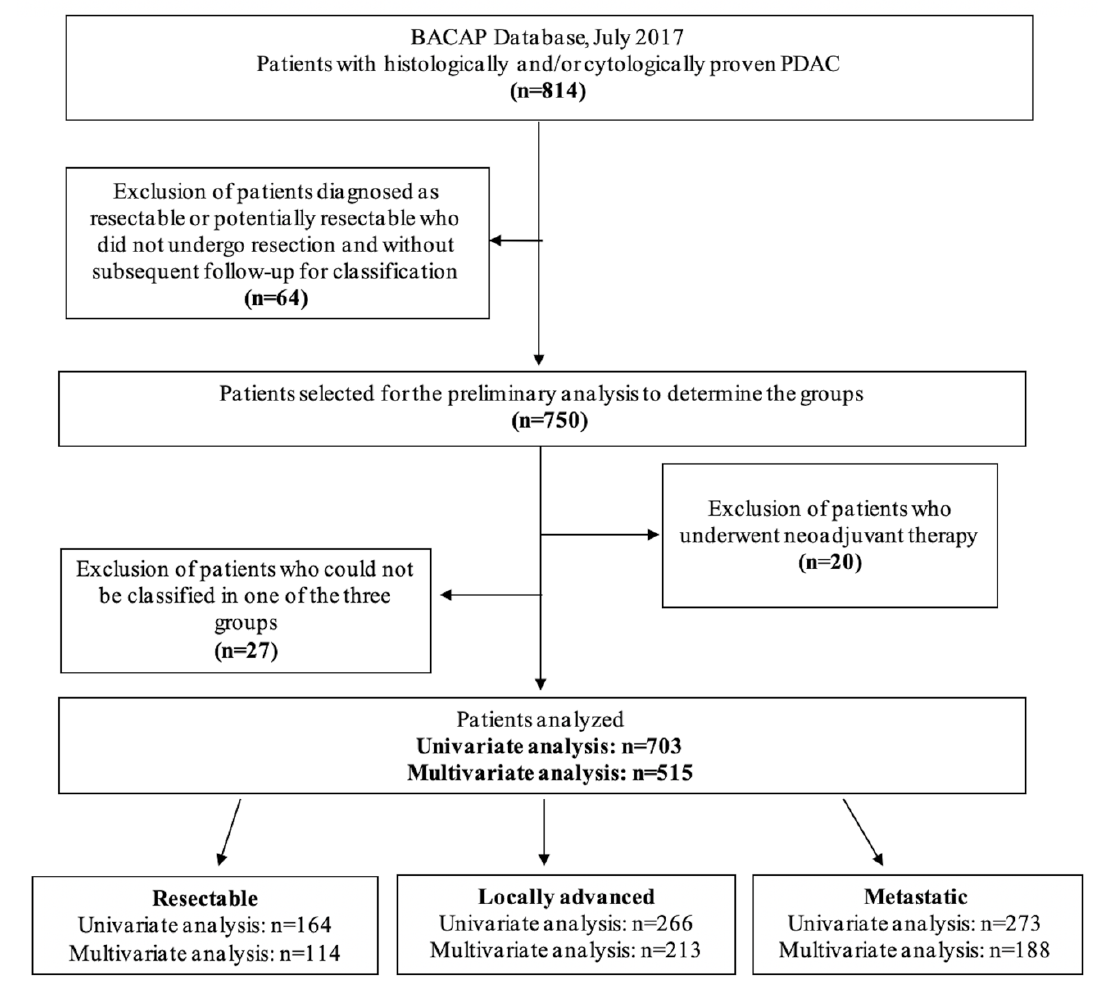
Figure 1. Flowchart. BACAP: National Anatomo-Clinical Database on Pancreatic Adenocarcinoma; PDAC: pancreatic ductal adenocarcinoma.